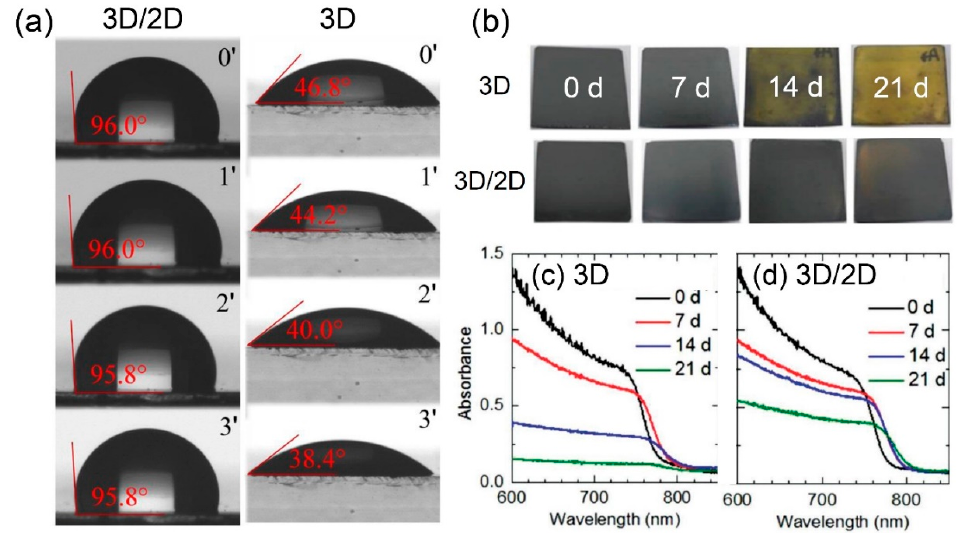
Figure 8. E ff ect of the 3D / 2D bilayered structure on the moisture resistance. ( a ) Contact angle of the water droplet contact angle on top of 3D / 2D (left) and 3D (right) as a function of the loading time. Reprinted with permission from Ref. [25] Copyright 2019 AAAS. ( b ) Optical color changes of 3D (top) and 3D / 2D (bottom) films stored in a closed vessel with 85 ± 10%. UV-Vis absorption spectra of ( c ) 3D and ( d ) 3D / 2D films stored in a closed vessel with 85 ± 10%. Reprinted with permission from Ref.